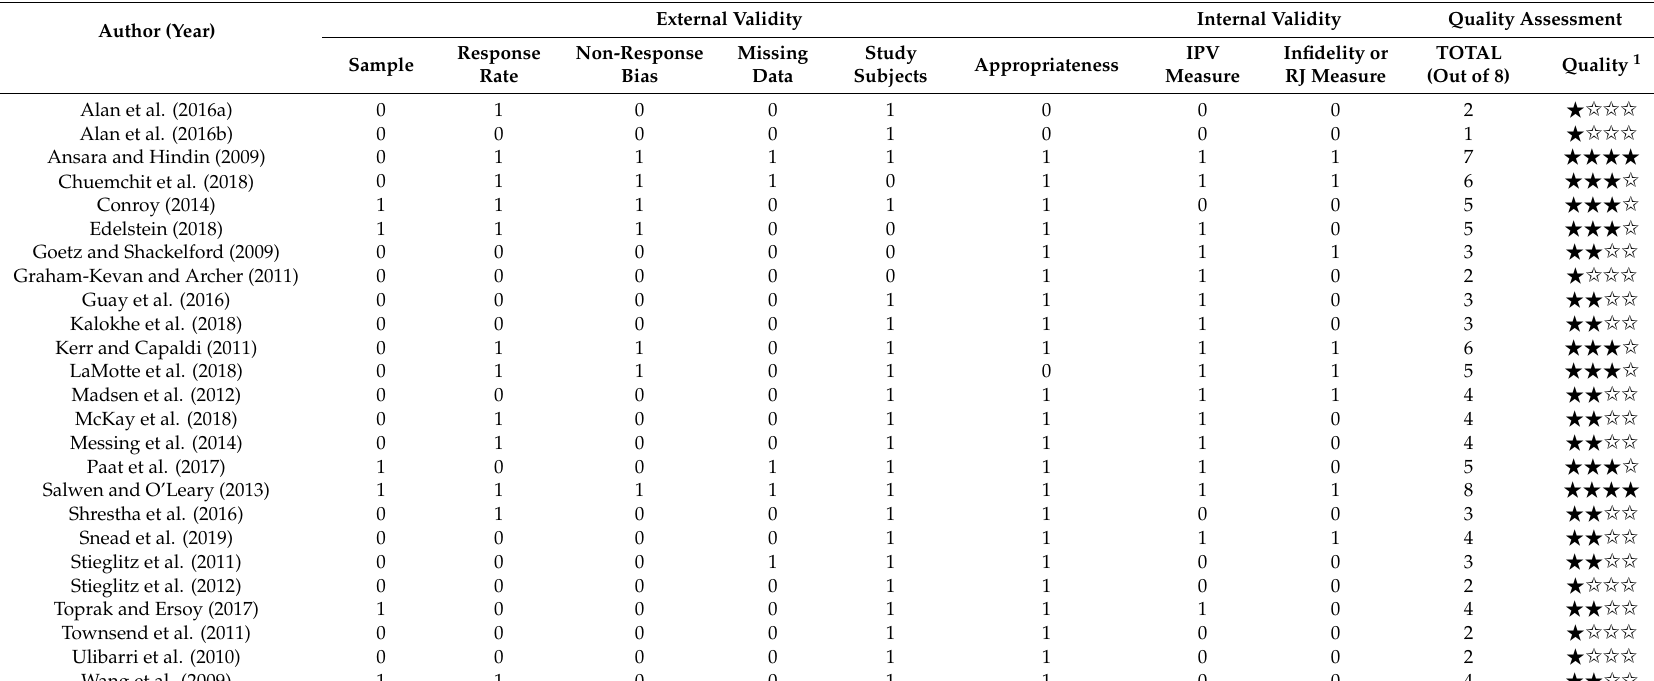
Table A2. Quality assessment of included quantitative